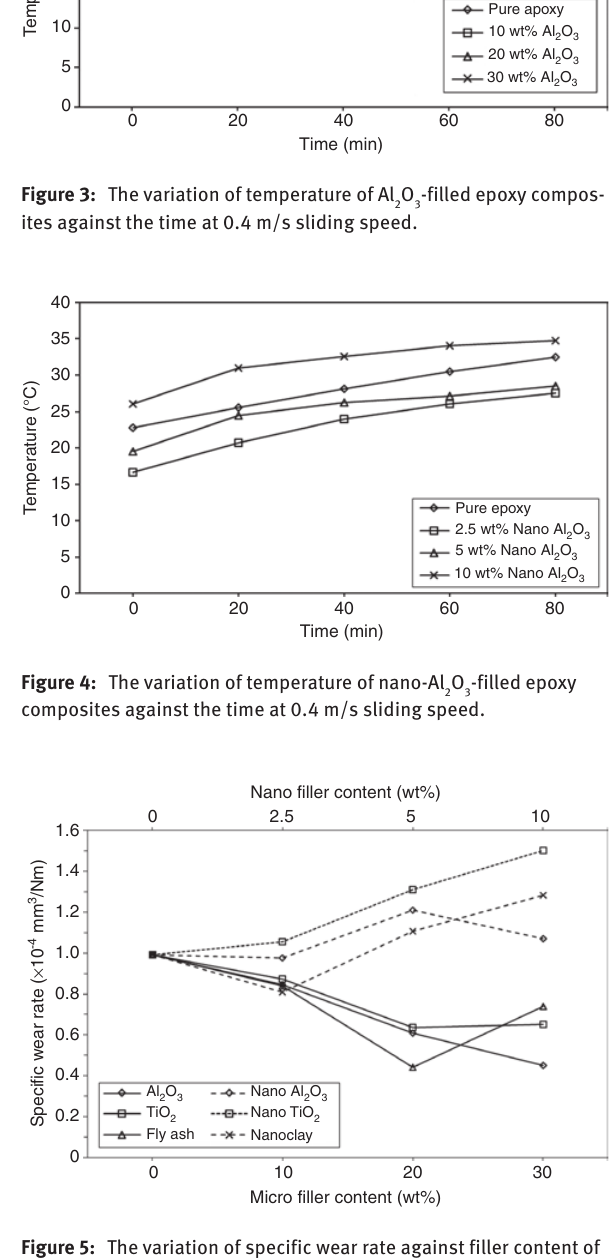
Figure 2: The relationship of coefficient of friction against filler content of micro- and nanoepoxy composites at 0.4 m/s sliding speed and 15 N load conditions.